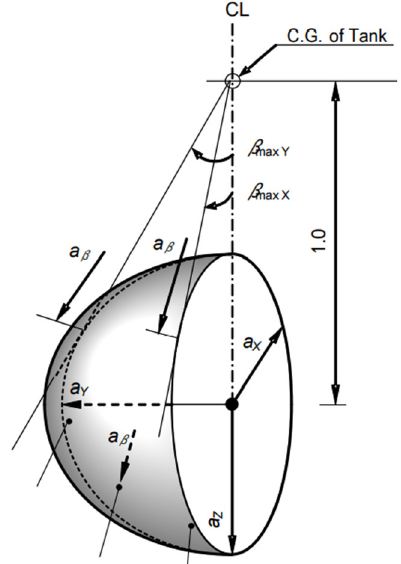
Figure 11. Acceleration ellipsoid [2].